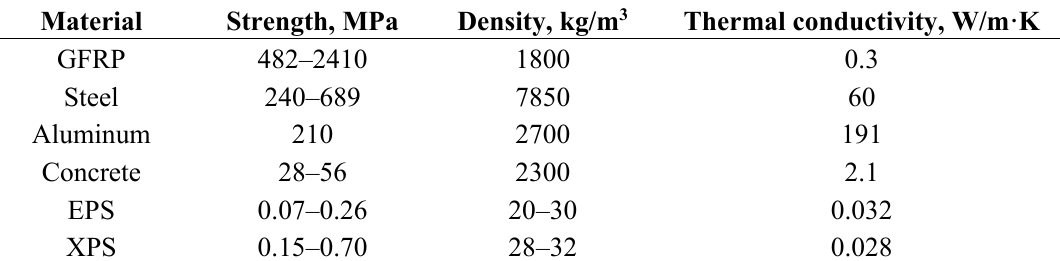
Table 1. Material properties of the shear connectors [17–19].